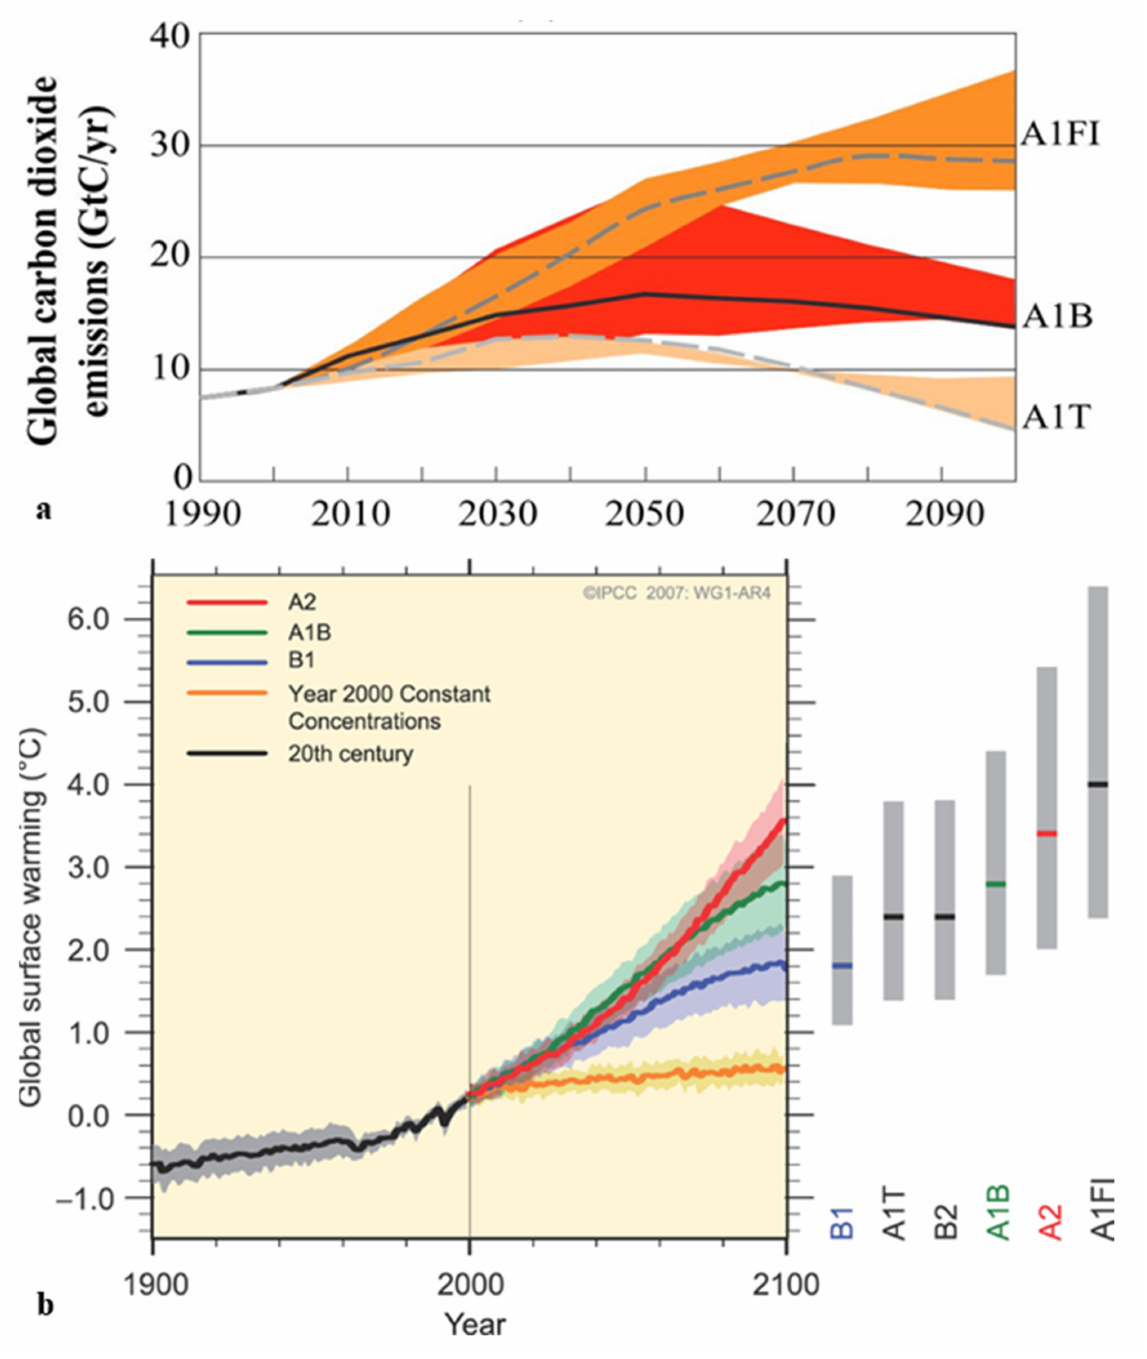
Figure 2. The IPCC emissions scenarios ( a ) and the related global surface warming ( b ). Converted by the summary for policymakers